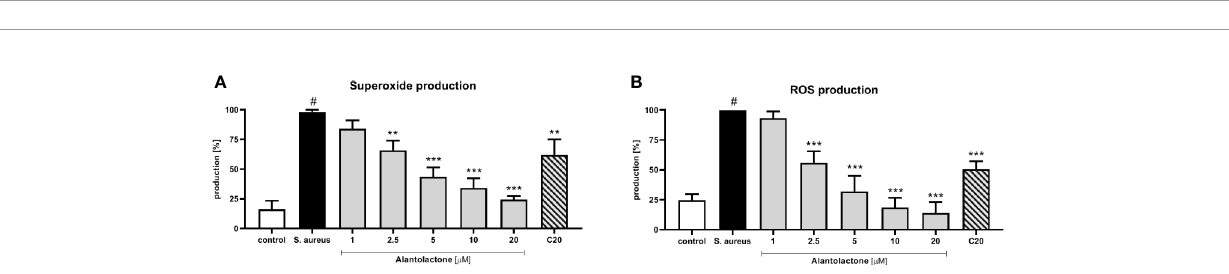
FIGURE 6 | The in fl uence of alantolactone on (A) superoxide and (B) ROS production by S.aureus -stimulated THP-1 cells. Statistical signi fi cance: *p < 0.05, **p < 0.01, ***p < 0.001 versus stimulated control (ANOVA and Dunnett ’ s post hoc test); control — non-stimulated control; S. aureus — S.aureus -stimulated control. # statistically signi fi cant (p < 0.001) versus non-stimulated